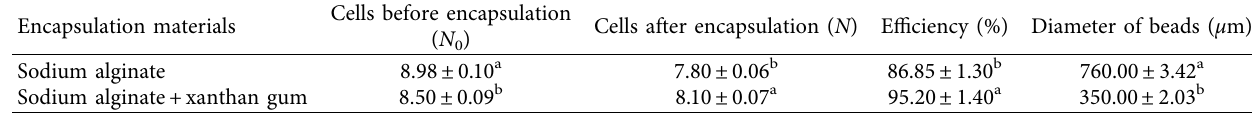
Table 2: Encapsulation efciency of alginate and alginate gum-coated microbeads. Cells before Encapsulation materials